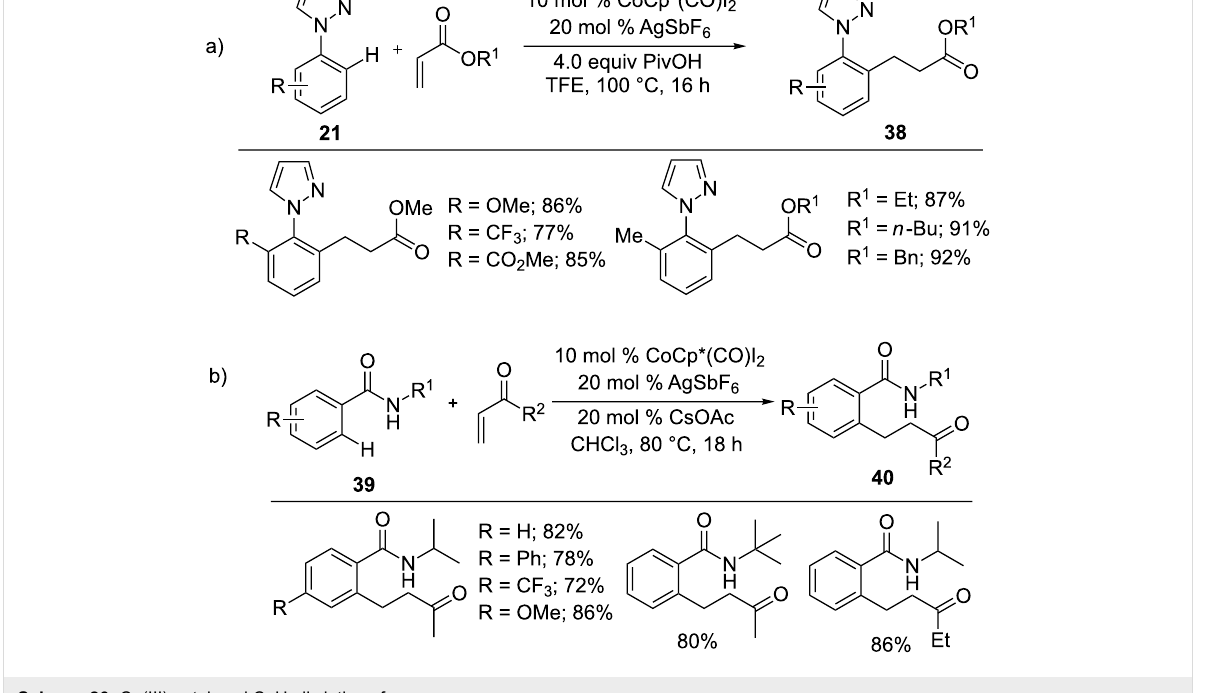
Scheme 26: Co(III)-catalyzed C–H alkylation of arenes.